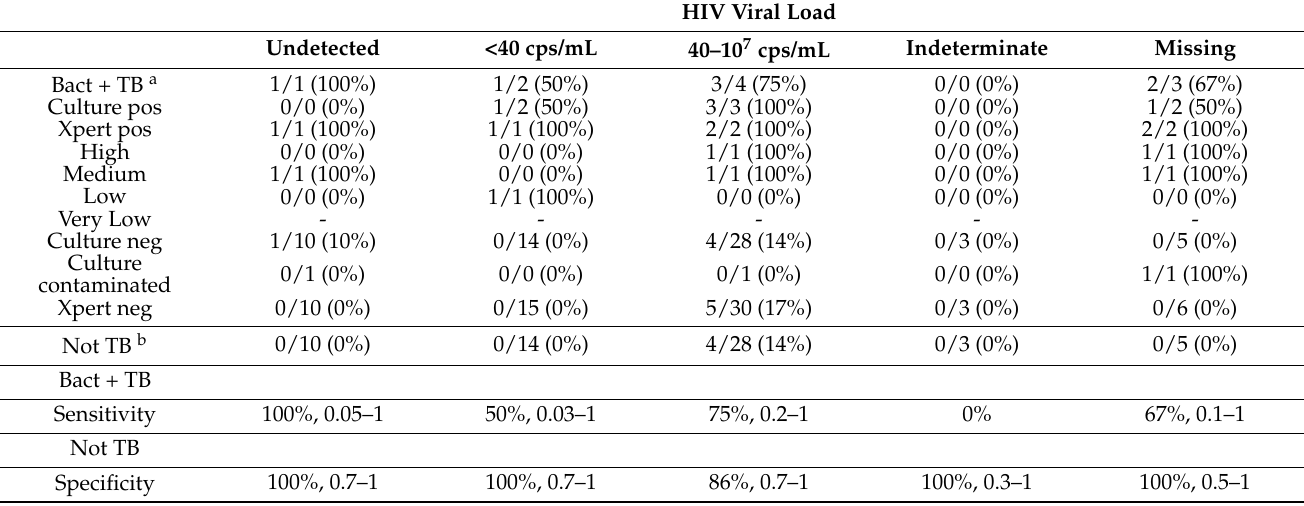
Table 4. Positive FujiLAM test results among HIV positive participants by TB status and HIV RNA viral